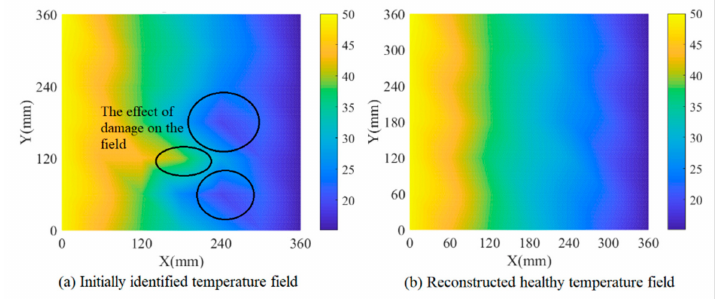
Figure 8. Temperature field identification results of simulation model 2.